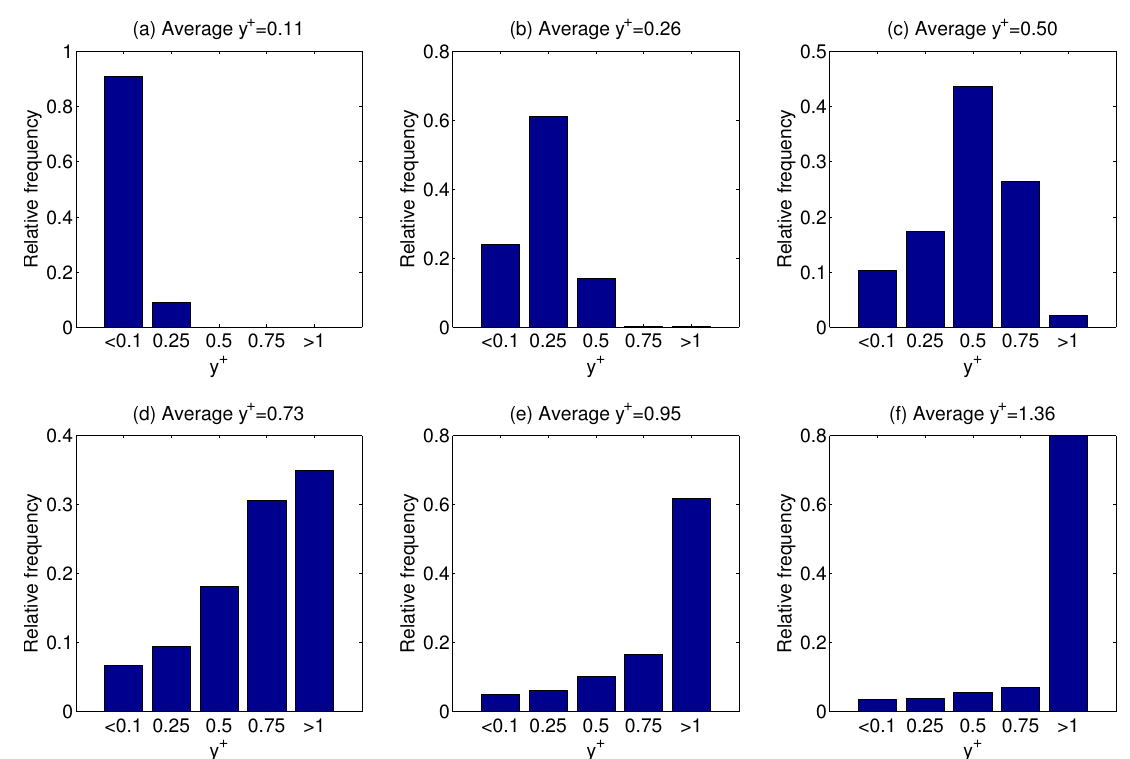
Figure 4. The histogram of the acquired y + values for the H3 hull for the average ( a ) y + = 0.11, ( b ) y + = 0.26, ( c ) y + = 0.50, ( d ) y + = 0.73, ( e ) y + = 0.95 and ( f ) y + = 1.36.